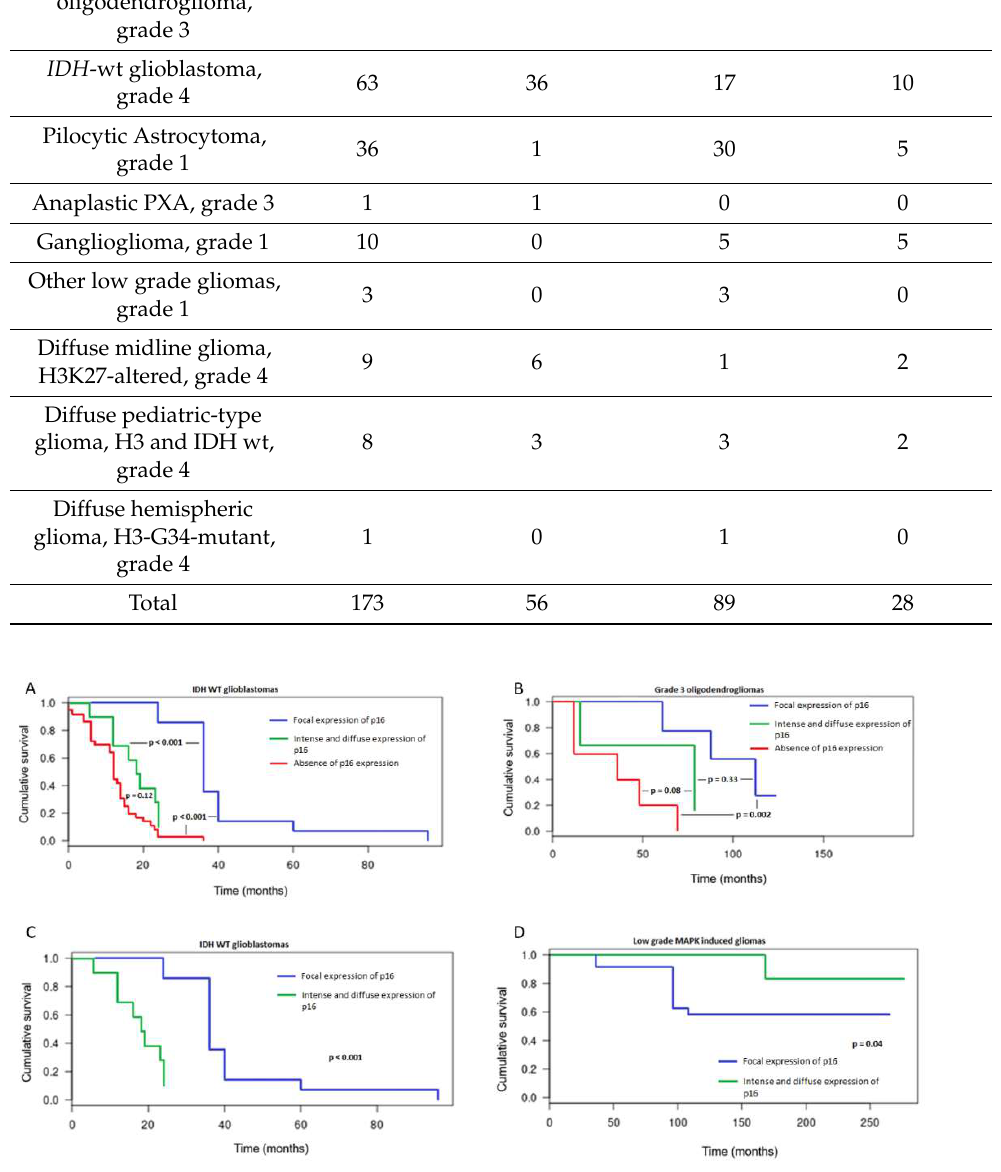
Figure 2. Kaplan–Meier survival curves according to the pattern of p16 expression in IDH -wt glioblastomas ( A ) and IDH mutant 1p/19q codeleted oligodendrogliomas (grade 3) ( B ). Comparison of Kaplan–Meier survival curves according to the pattern of p16 expression in IDH -wt glioblastomas and MAPK-induced gliomas ( C , D ). p -value under 0.05 was considered statistically significant.